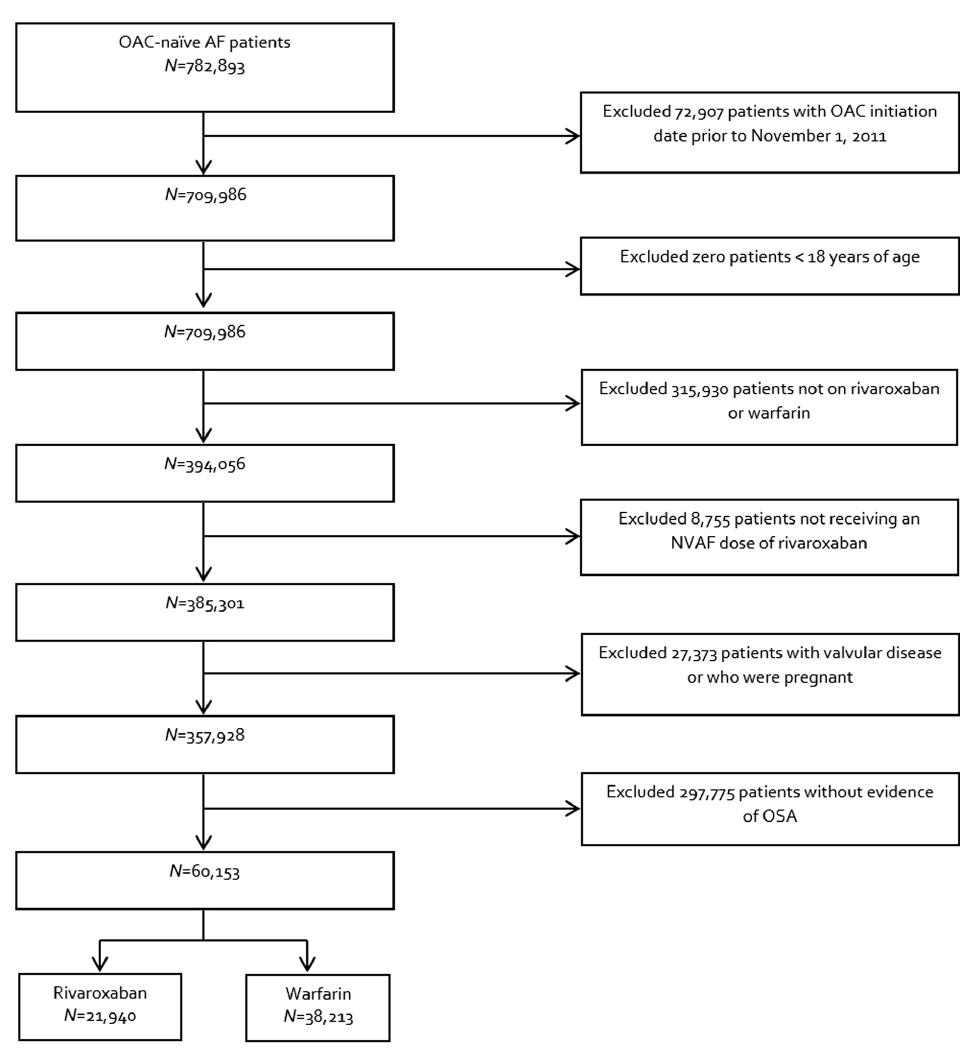
Fig. 1 Patient inclusion and exclusion. AF, atrial fi brillation; NVAF, nonvalvular atrial fi brillation; OAC, oral anticoagulant; OSA, obstructive sleep